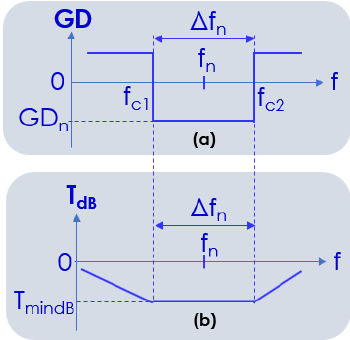
FIGURE 2. Graphical NGD specifications: (a) GD and (b)